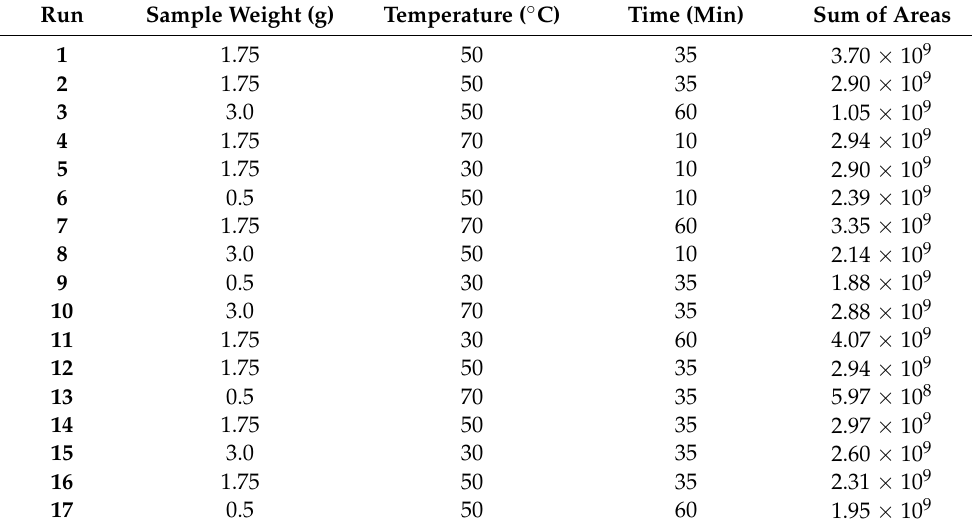
Table 1. Combinations of experiment conditions of the Box–Behnken design (BBD) and the measured sum of areas of common volatile compounds present in celery